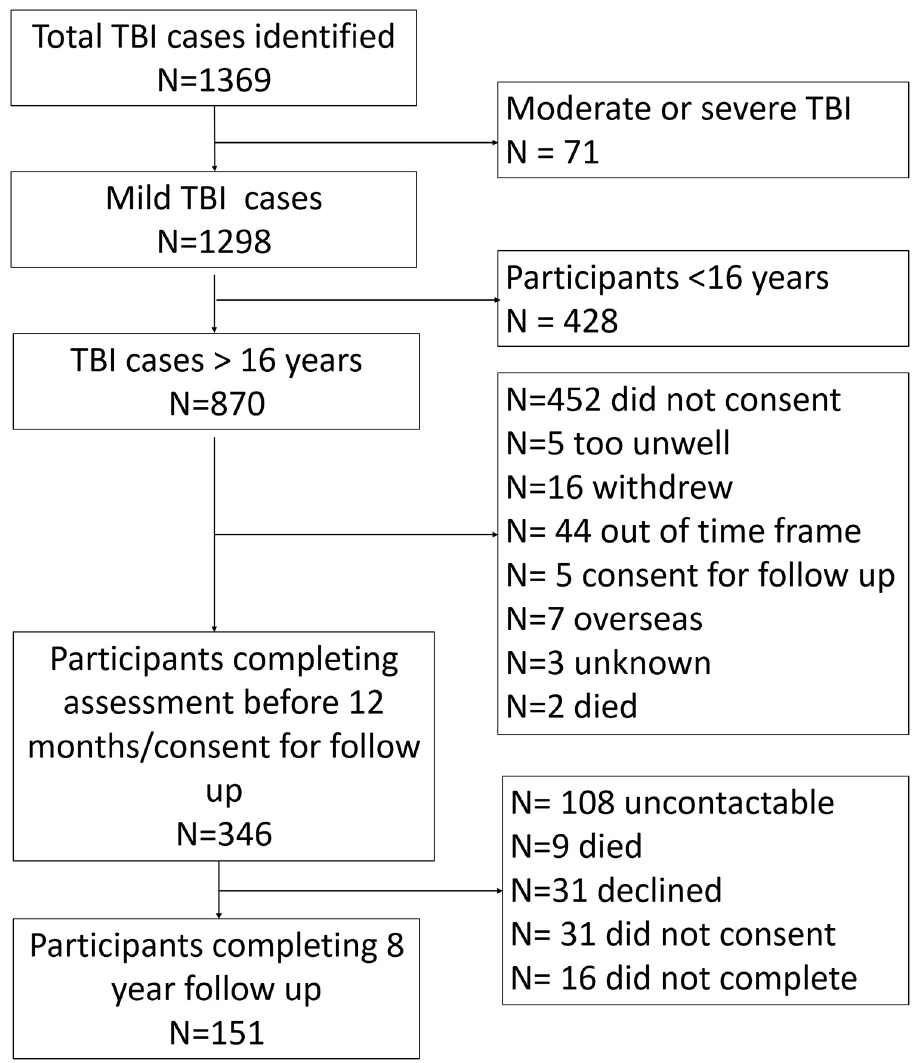
Fig 1. Participant flow through the